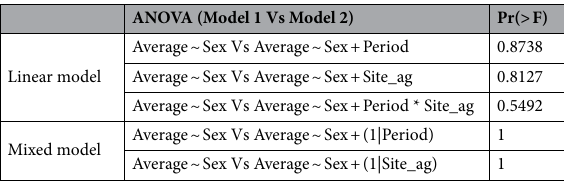
Table 3. ANOVA results for the tested linear models.